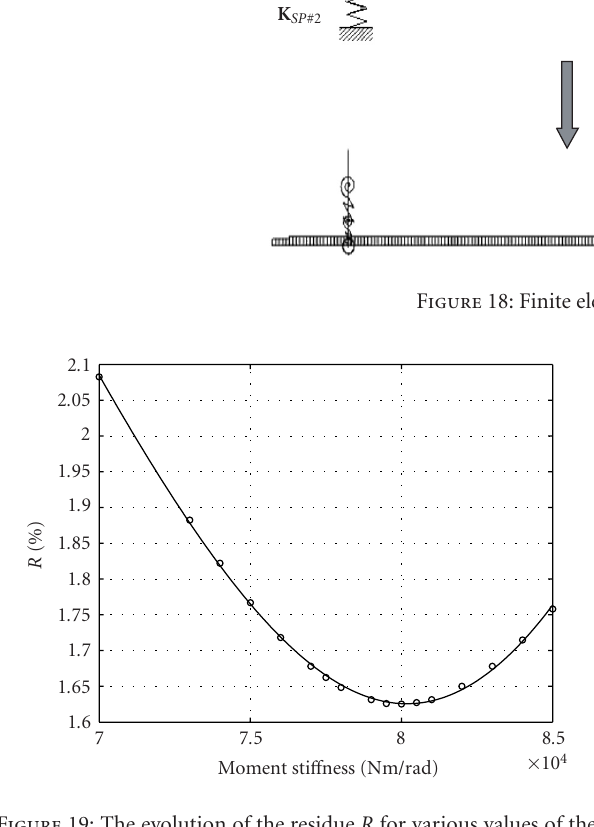
Figure 19: The evolution of the residue R for various values of the moment sti ff ness of the two bearings.